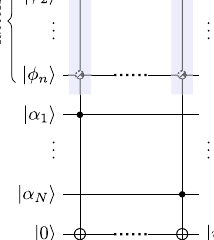
1 ), a -triggered control ( | � •